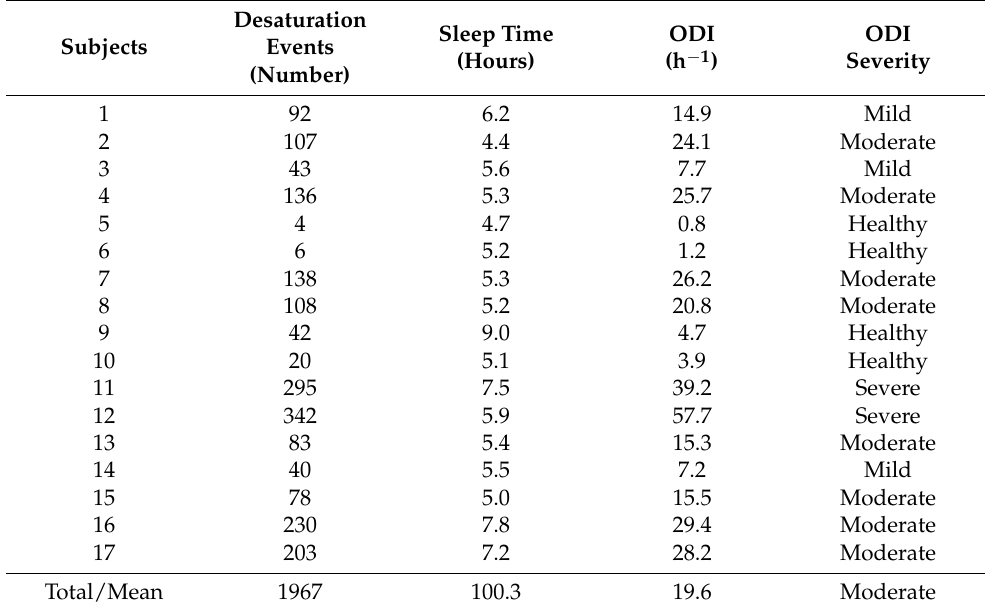
Table 2. Number of desaturation events, sleep time, ODI, and ODI severity for each of the subjects of the database. Desaturation Subjects